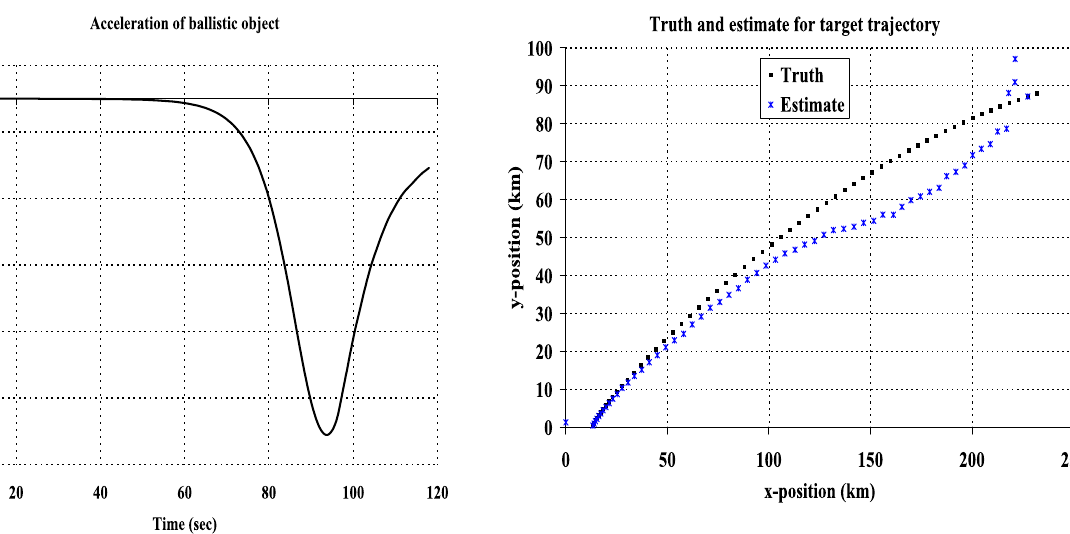
Fig. 3 Acceleration of ballistic target versus time